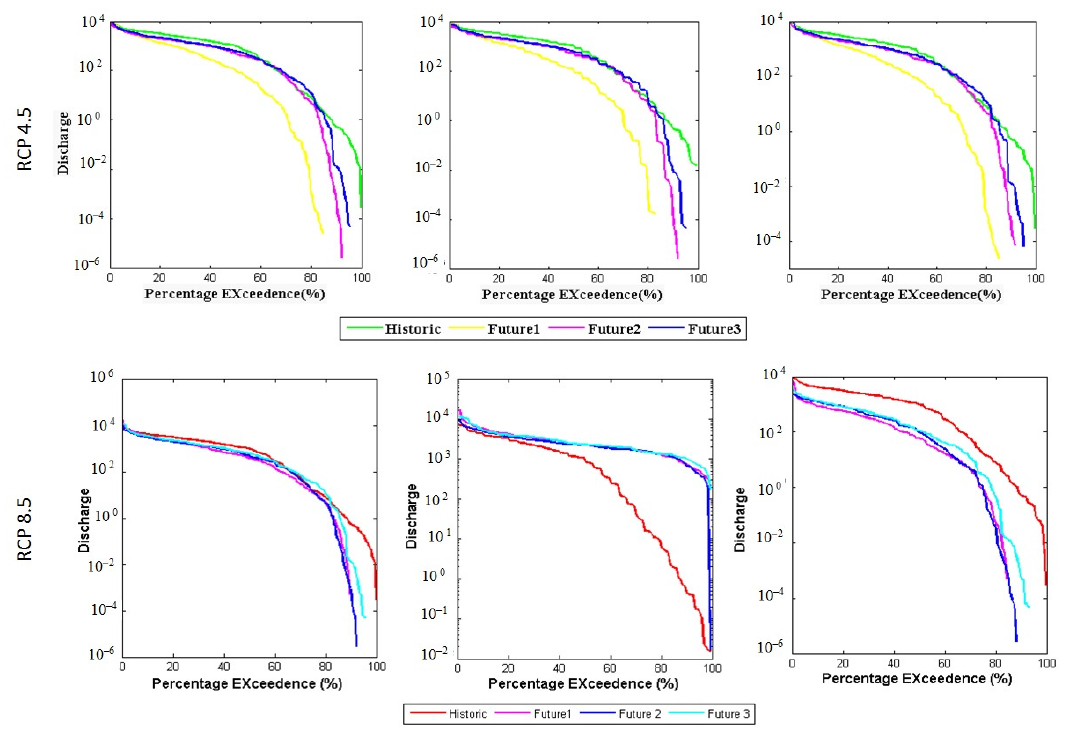
Figure 8. Annual, monsoon, and non-monsoon flow duration curves at the Huvinhedgi gauge station for historic and future periods under RCP 4.5 and RCP 8.5 scenarios.